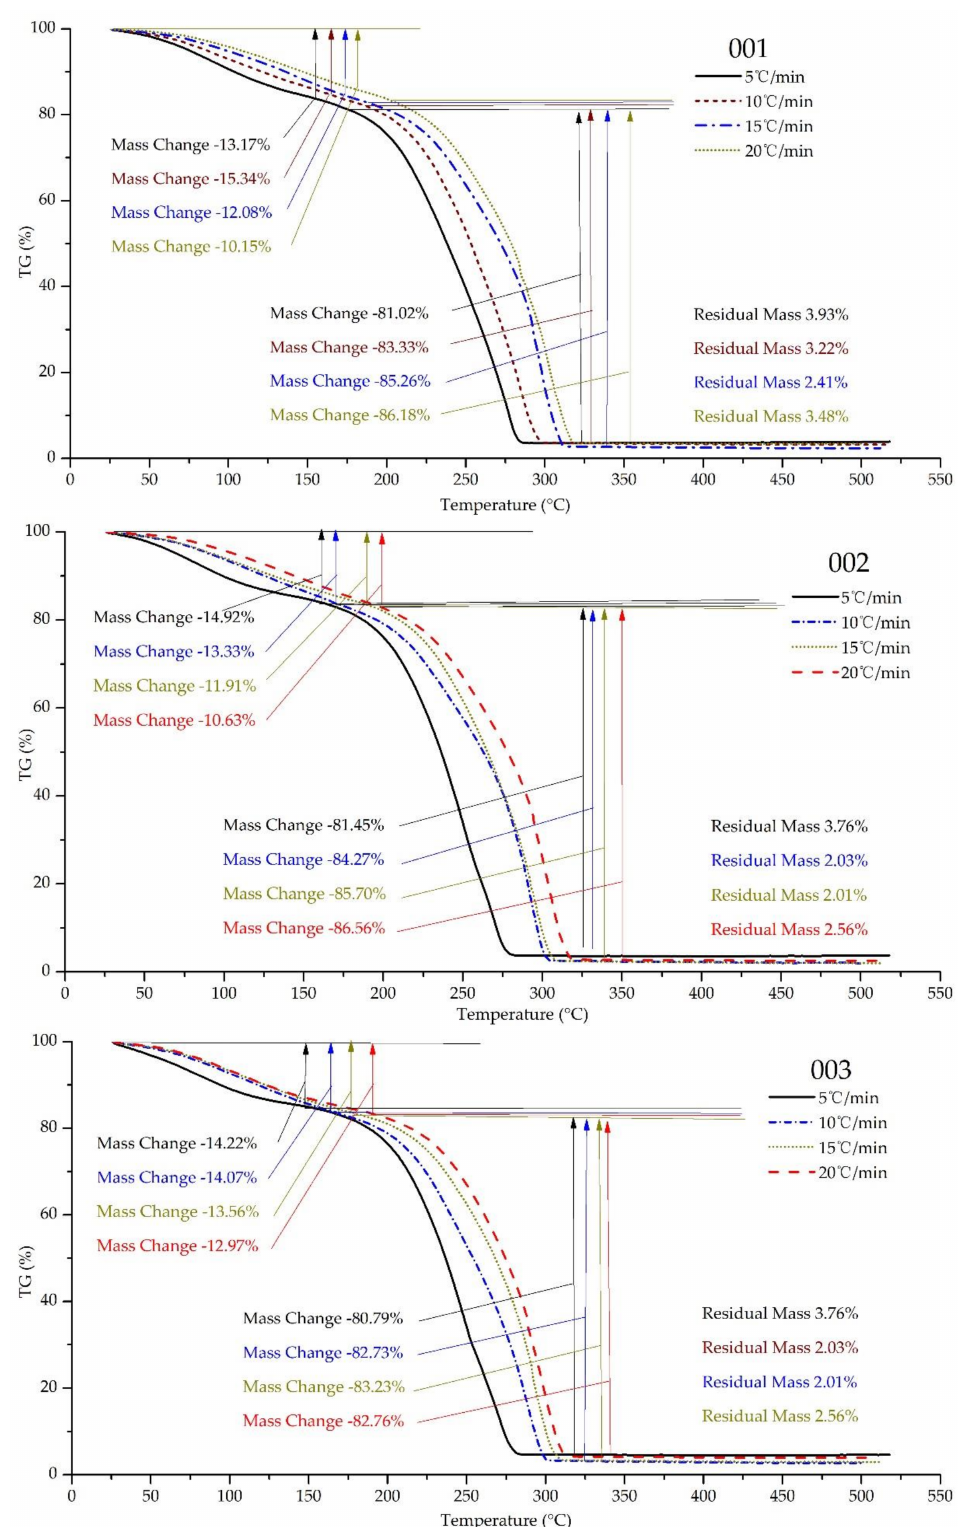
Figure 1. The TG curves of the emulsion explosives matrix samples 000 to 003 at different heating rates under a nitrogen